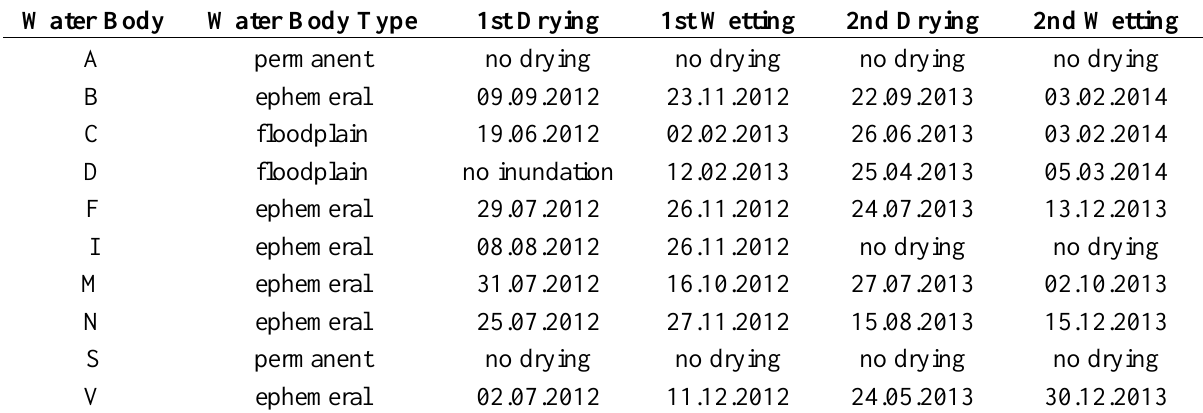
Table 1. Location (Figure 1) and type of water body as well as transition dates for